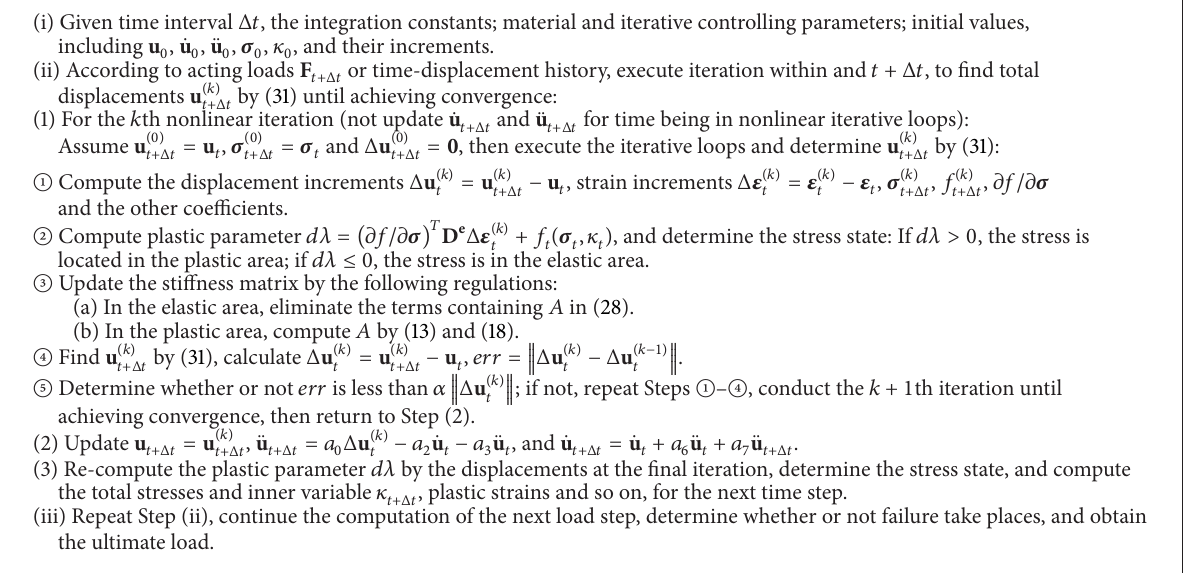
Box 3: Whole amount iterative scheme of elastoplastic dynamical